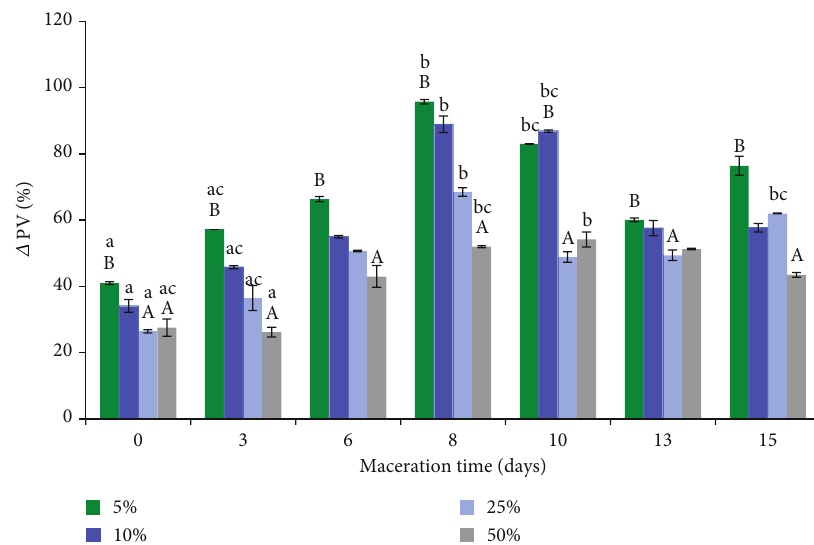
Figure 2: The e ff ect of the addition of di ff erent concentrations of sage macerate (5%M-50%M), applied after a di ff erent day of maceration, on CLO quality parameters, expressed as delta ( Δ ) of peroxide value (PV), in the UV test (Values marked with the same lowercase letter a, ac, … , do not di ff er statistically signi fi cantly ( p < 0 : 05 ) within each macerate concentration, while the values marked with the same uppercase letter — A, AC — do not di ff er statistically signi fi cantly ( p < 0 : 05 ) on individual maceration